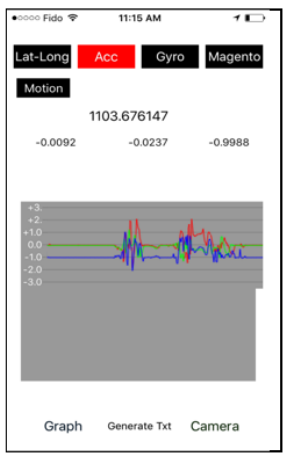
Figure 2. Developed Apple